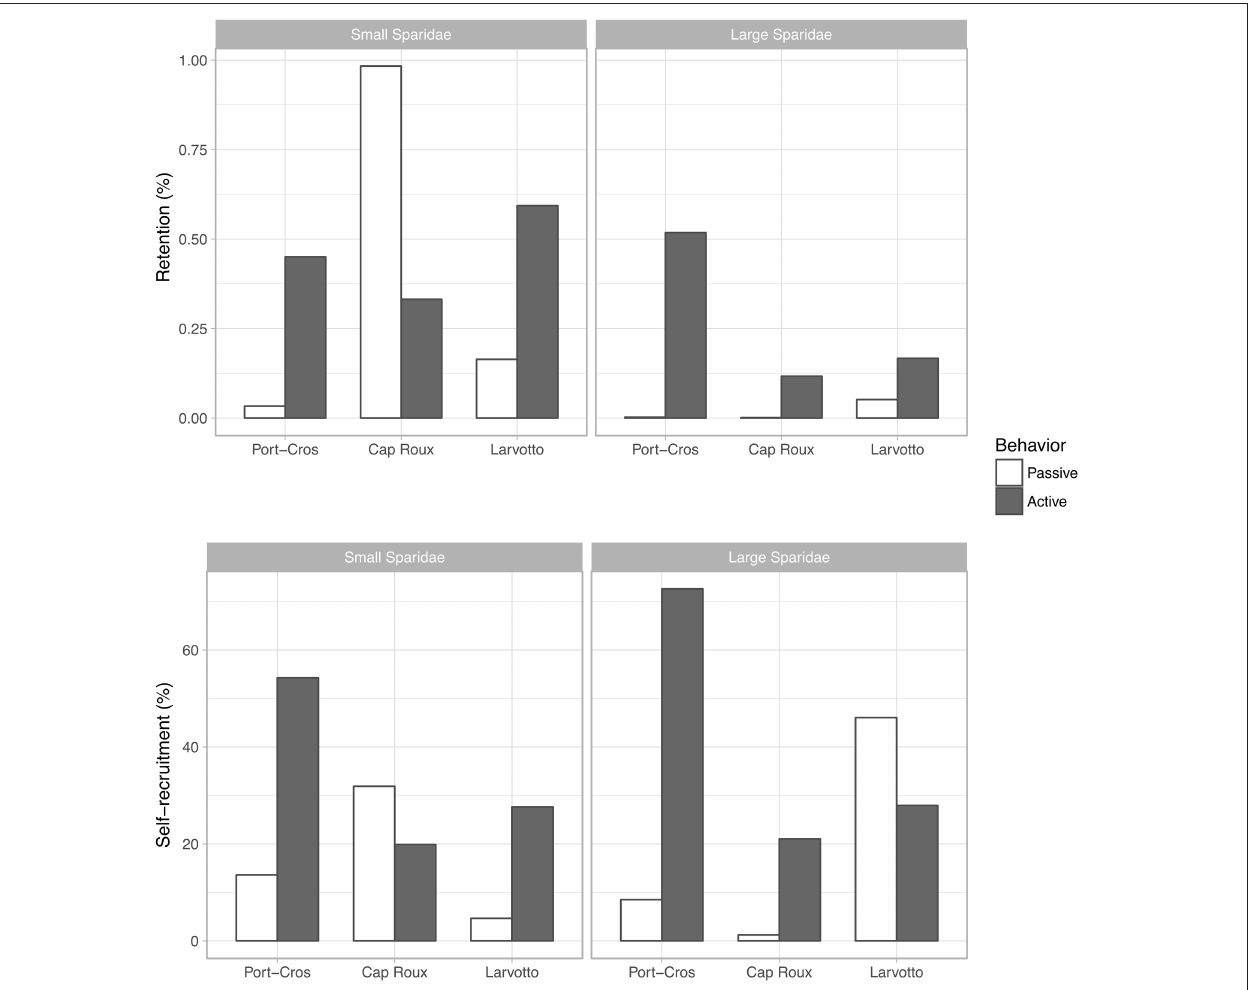
FIGURE 5 | Retention rate (i.e., number of virtual larvae that originated from and settled in a given MPA divided by the number of virtual larvae that were released from that MPA) and self-recruitment rate (i.e., same as self-retention but divided by the number of virtual larvae that successfully settled in the MPA) for each release MPA and group of